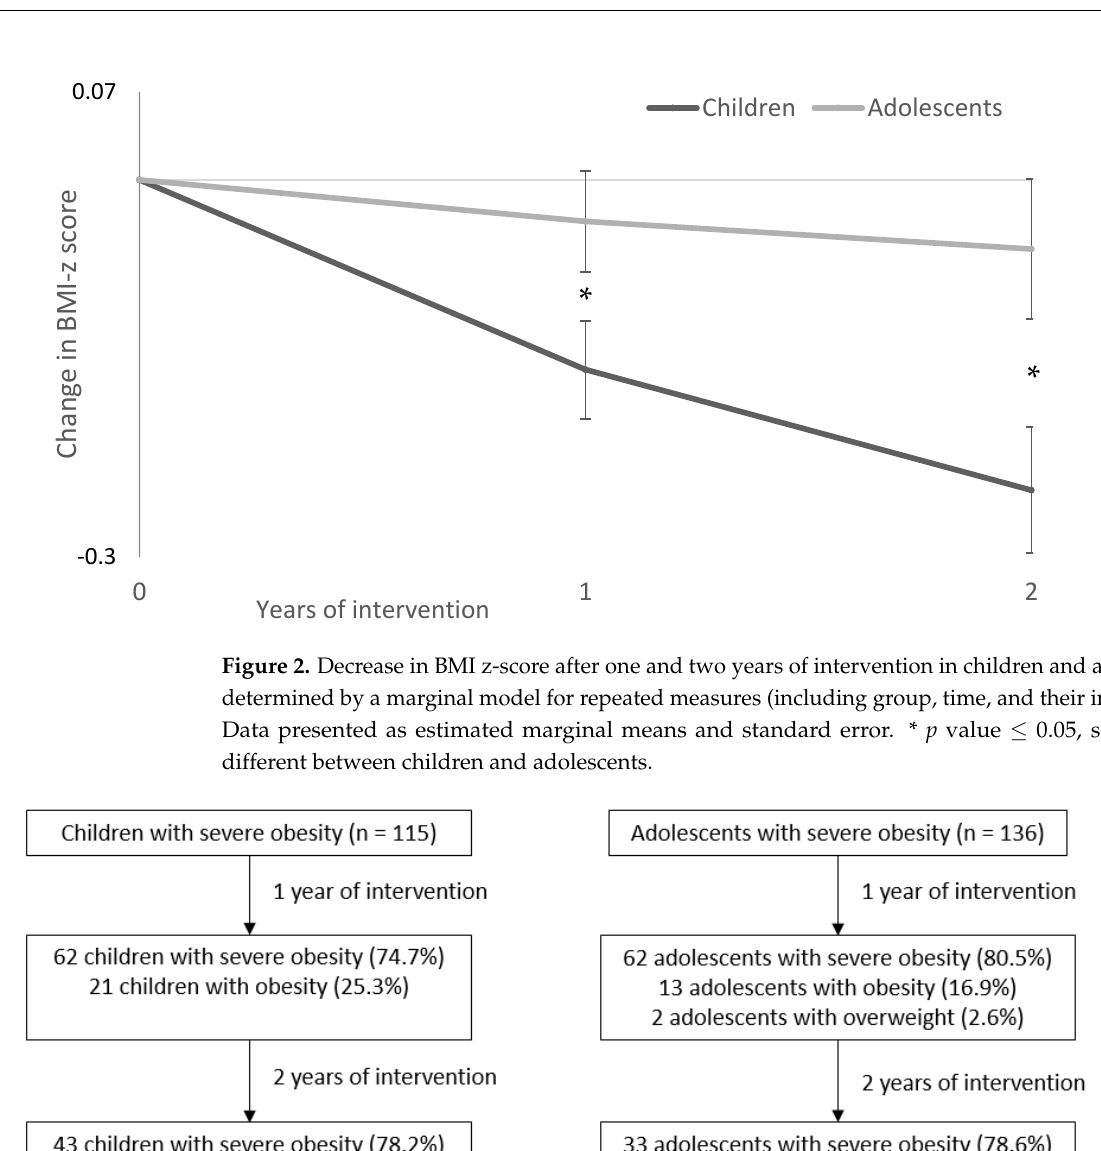
Figure 3. Change in IOTF criteria after one and two years of intervention presented in children and adolescents separately. Data presented as number (%). N = number, IOTF = International Obesity Task Force.